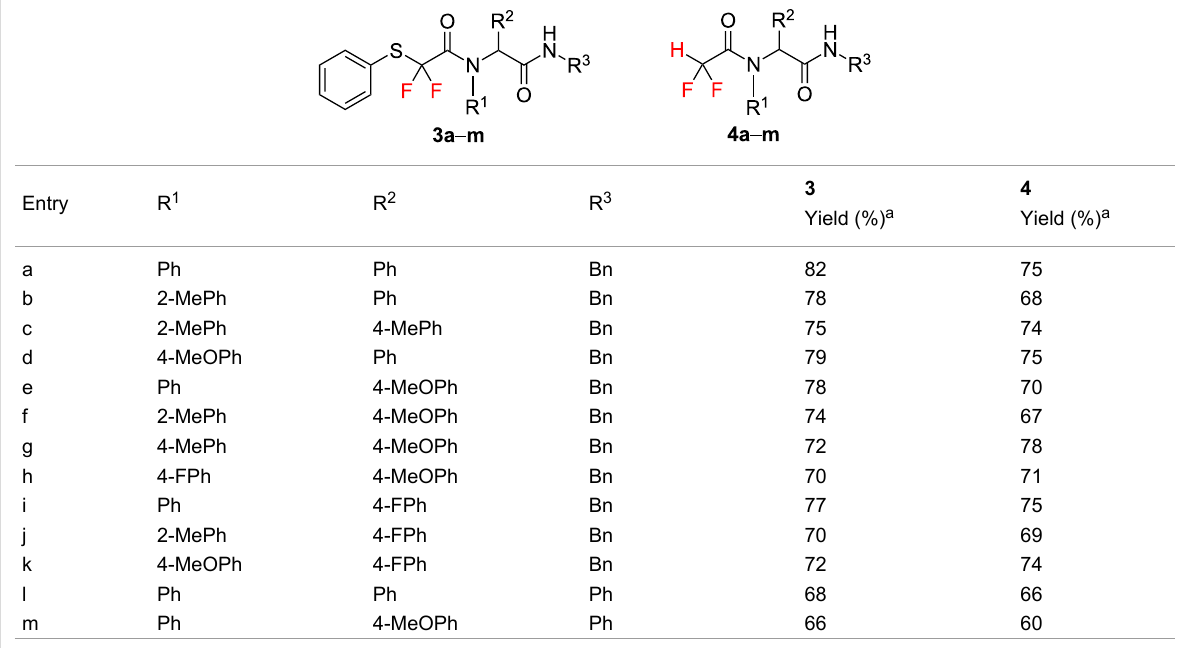
Table 1: Synthesis of difluoromethylene-containing pseudopeptides ( 3a – m ) and difluoromethyl-containing pseudopeptides ( 4a – m